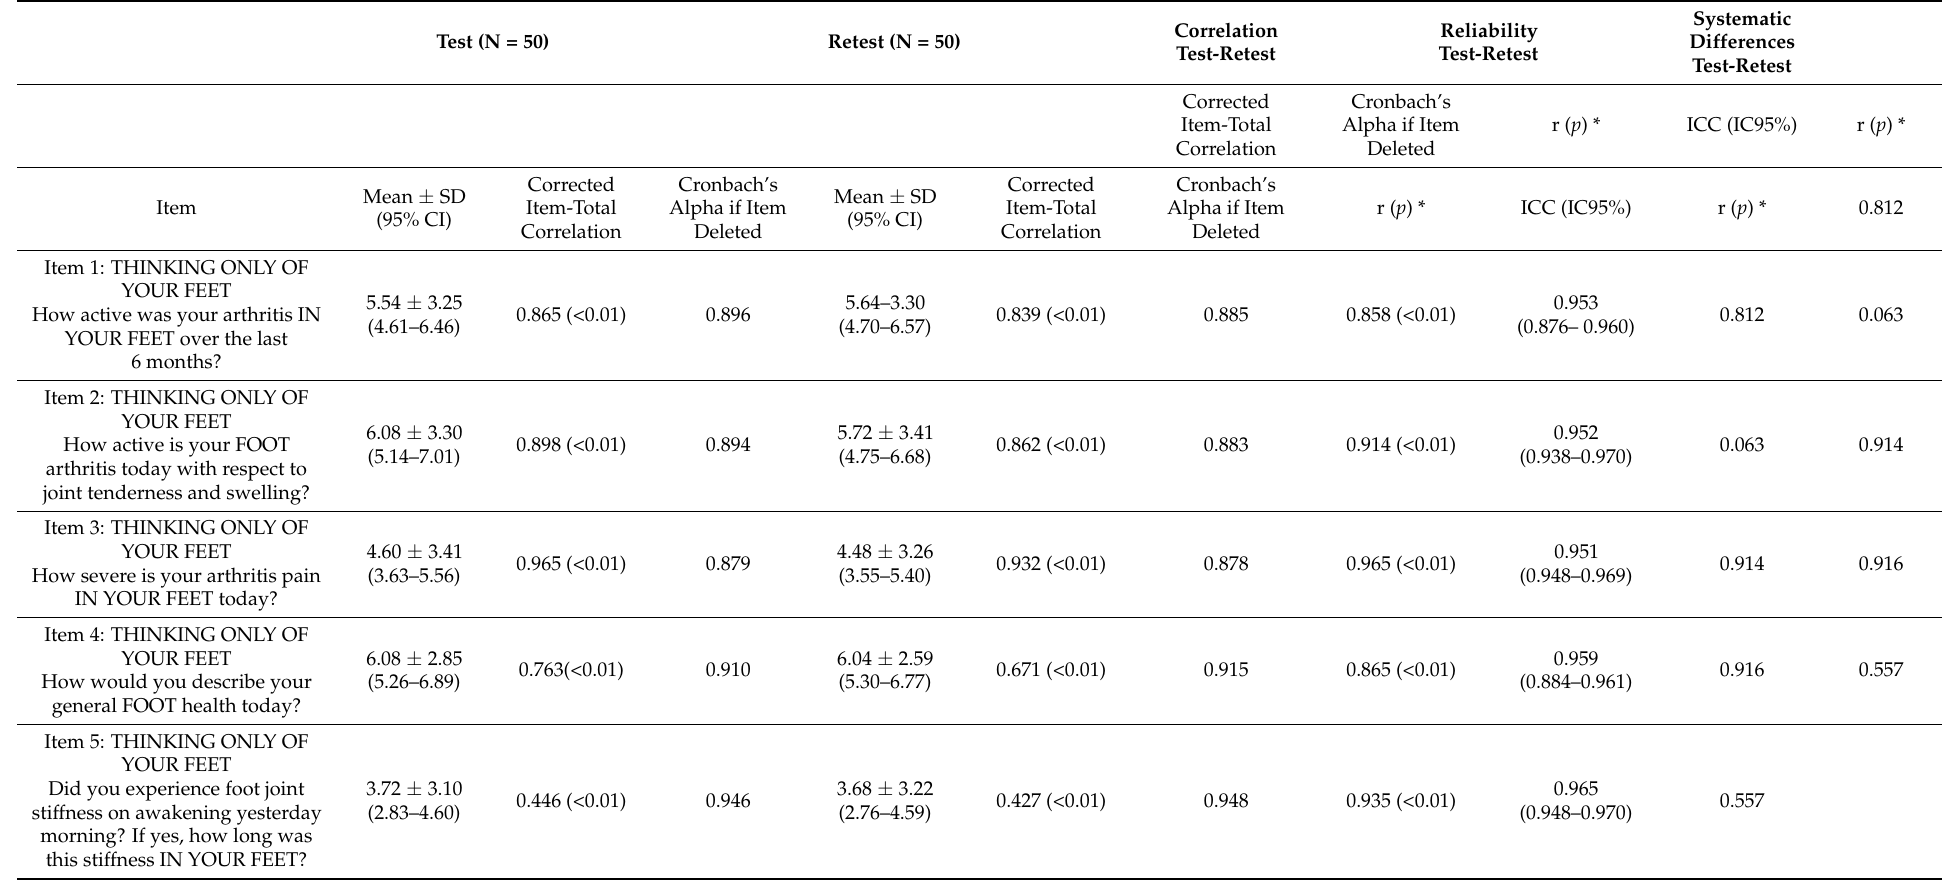
Table 3. Results of test-retest reliability, Item–total correlation and systematic differences of the RADAI-F5 according to each